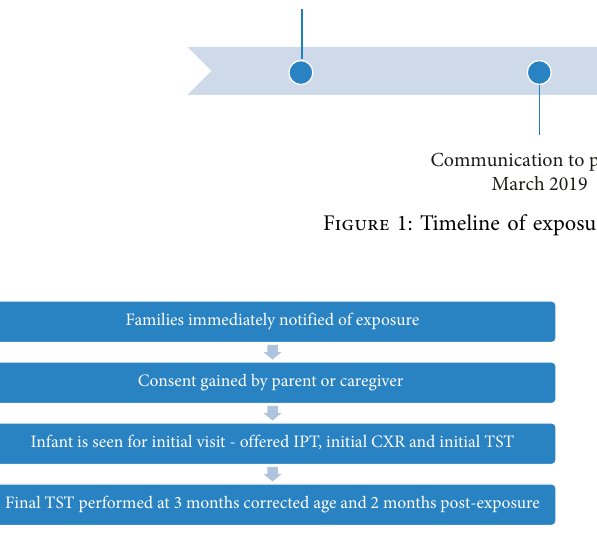
Figure 2: Procedures and methods involved in the study [13].